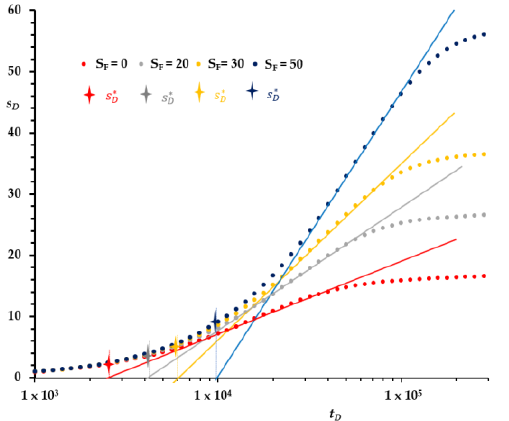
Figure 6. Example of drawdown s D * from graph s D vs. log t D (for S F = 0, 20, 30, 50, and for C D = 1 × 10 5 ).